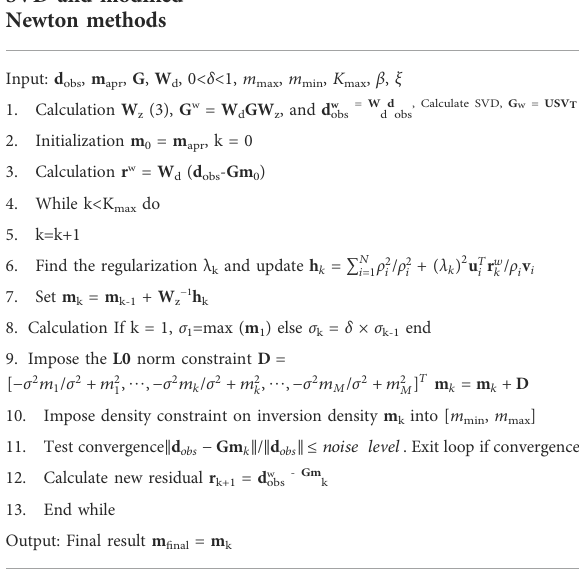
TABLE 1 Sparsity gravity inversion. Algorithm 1 sparsity inversion using the iterative SVD and modi fi ed Newton methods